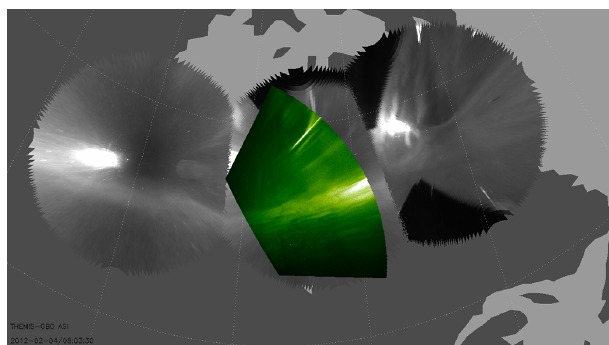
Figure 11. A comparison between a georeferenced ISS image (green) and data from the THEMIS ASI array (greyscale). The lo- cations of the large-scale features of the aurora are the same in the THEMIS and ISS data. The white saturated areas in the THEMIS images are caused by the